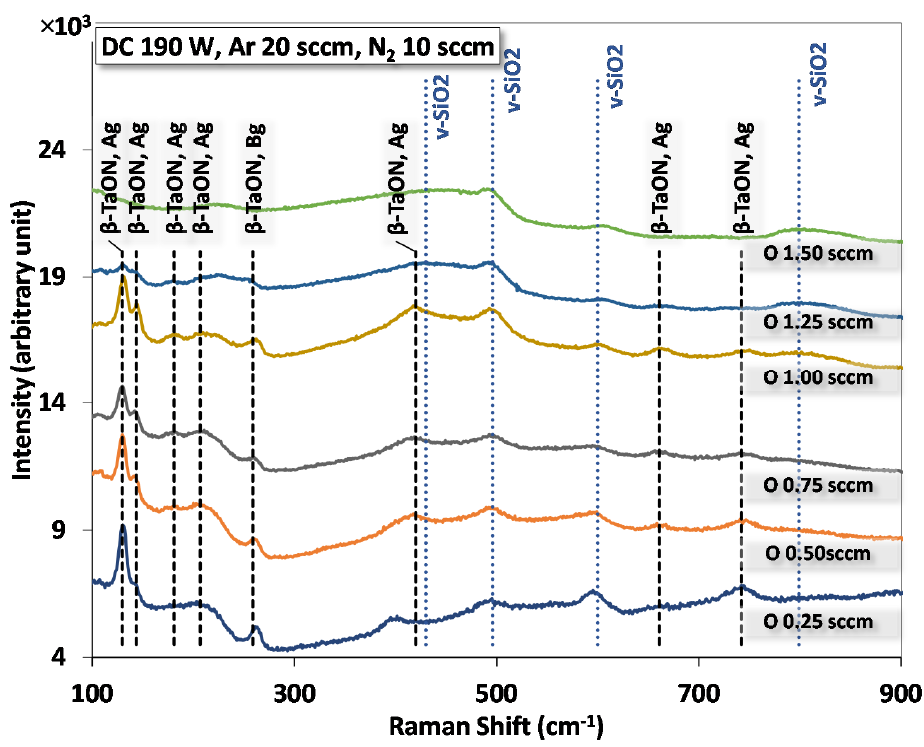
Figure 5. Raman spectra of annealed films under different oxygen flow rates. Table 2. Possible peaks in Raman spectra for tantalum oxynitride and silicon oxides (substrate).